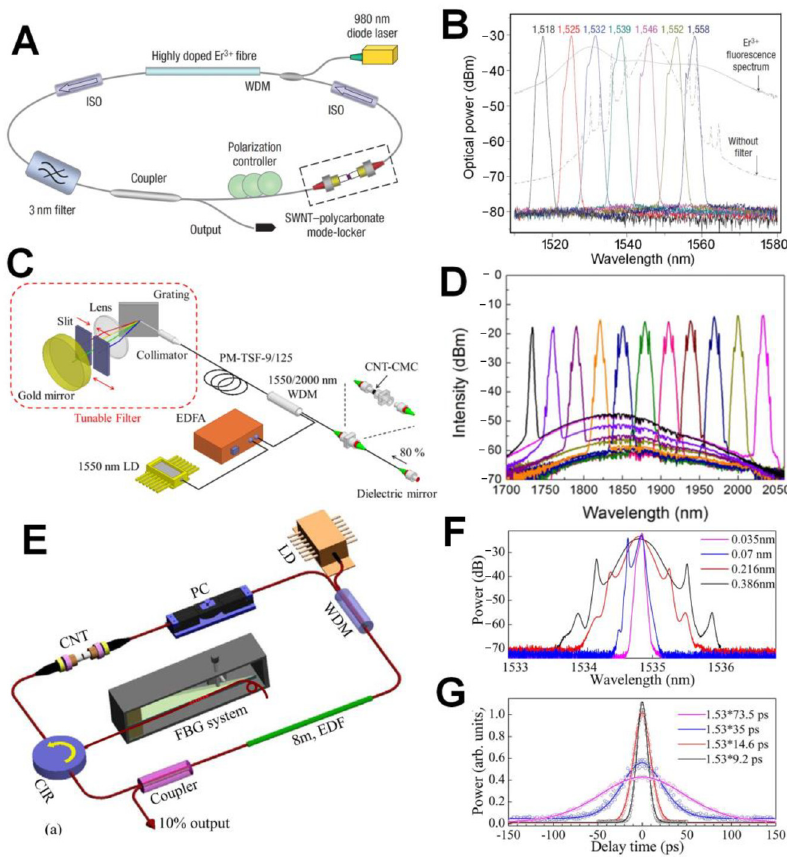
Figure 8: Wavelength and pulse